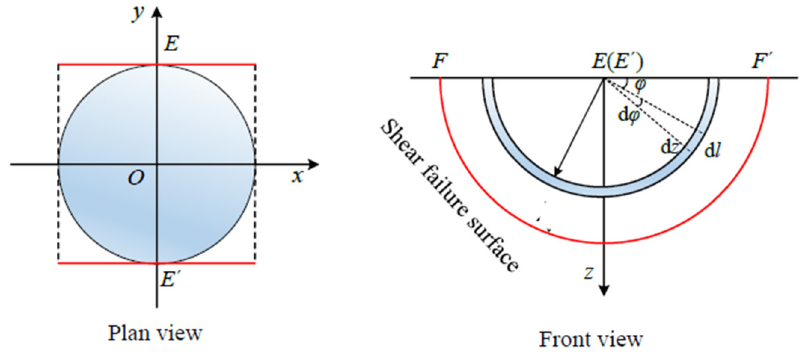
Figure 5. Sliding failure resistance moment.